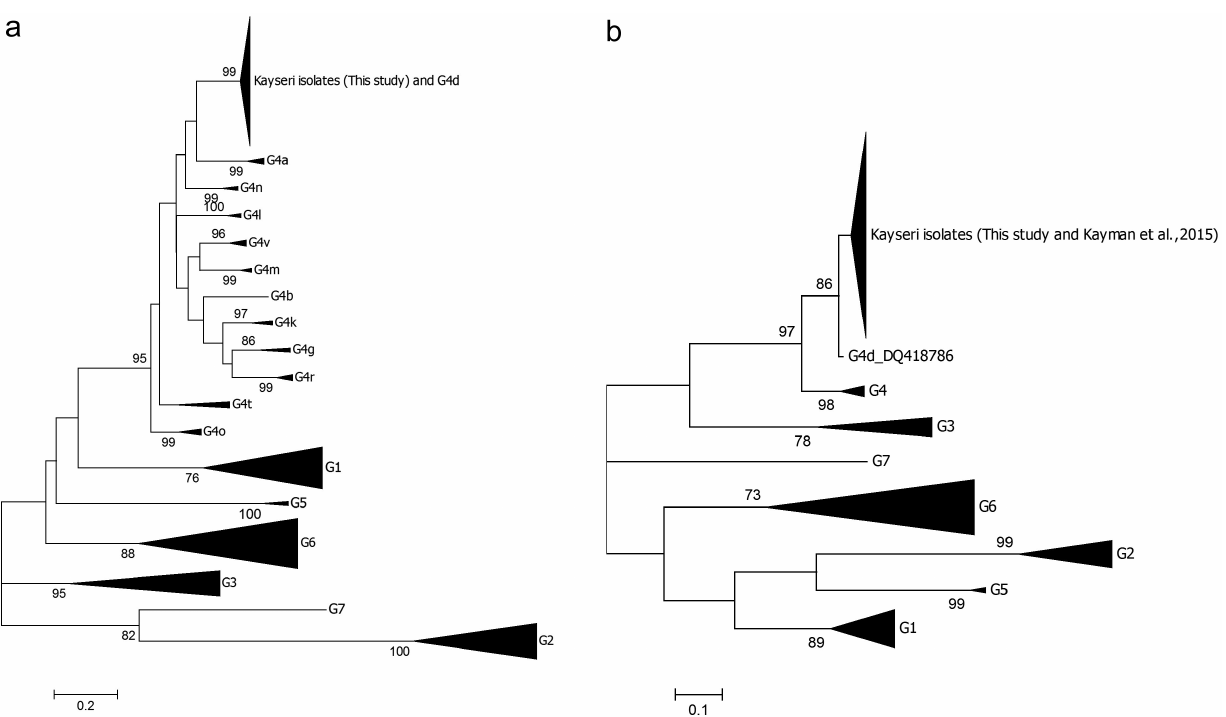
Figure 1. (a) The phylogenetic trees of Core/E1 nucleotide sequences from HCV genotype 4d Kayseri isolates in this study. (b) The phylogenetic trees of NS5B nucleotide sequences from HCV genotype 4d Kayseri isolates in this study and Kayman et al 16 2015.” The trees were constructed using Maximum Likelihood method with the General Time Reversible (GTR) model, Gamma distributed with Invariant sites (G+I) for 1000 replications. Bootstrap values lower than 70 are